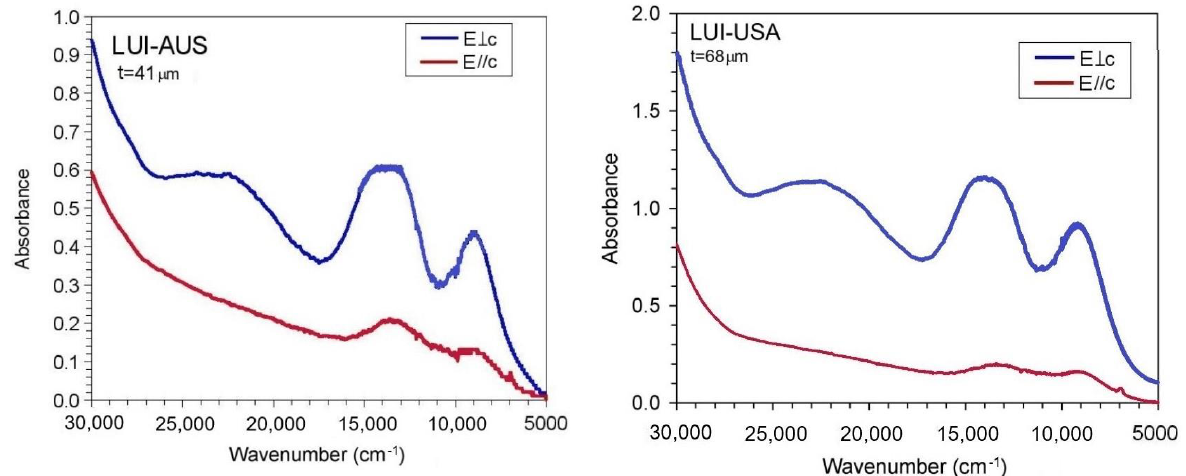
Figure 3. Polarized optical absorption spectra of the studied samples.